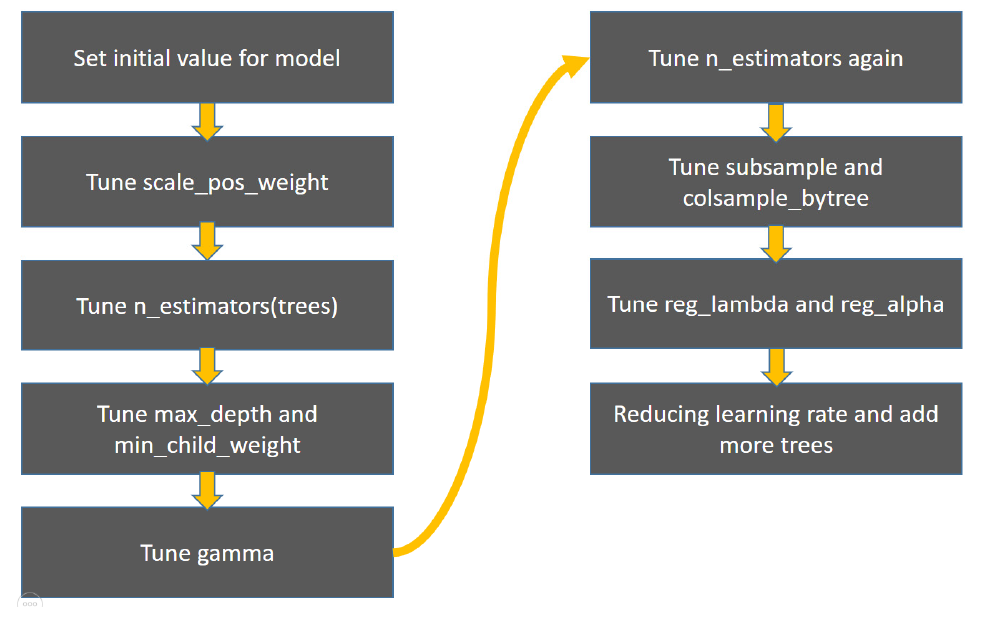
Figure 3. The training process of XGBoost.